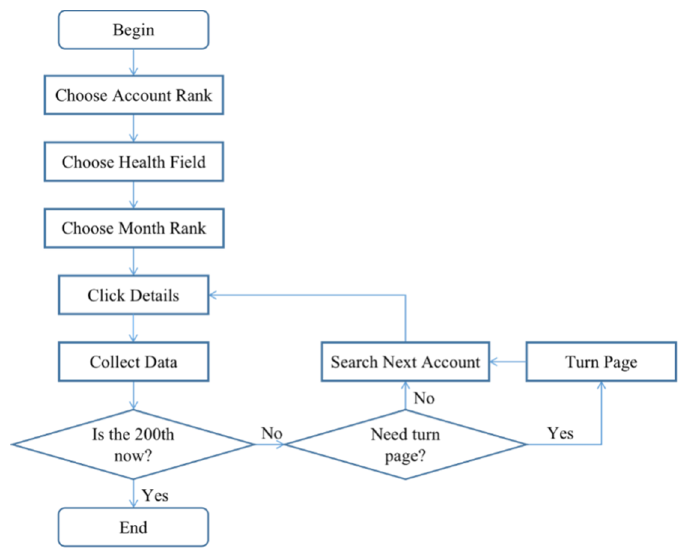
Table 2. Groups and numbers of official accounts .